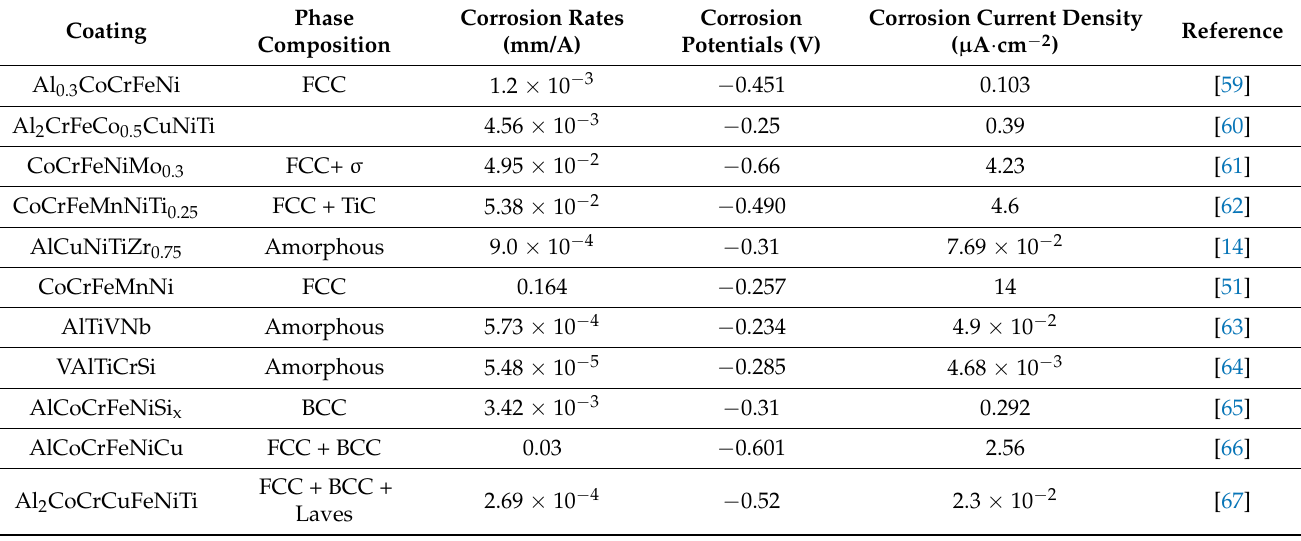
Table 2. Corrosion parameters of high-entropy alloy